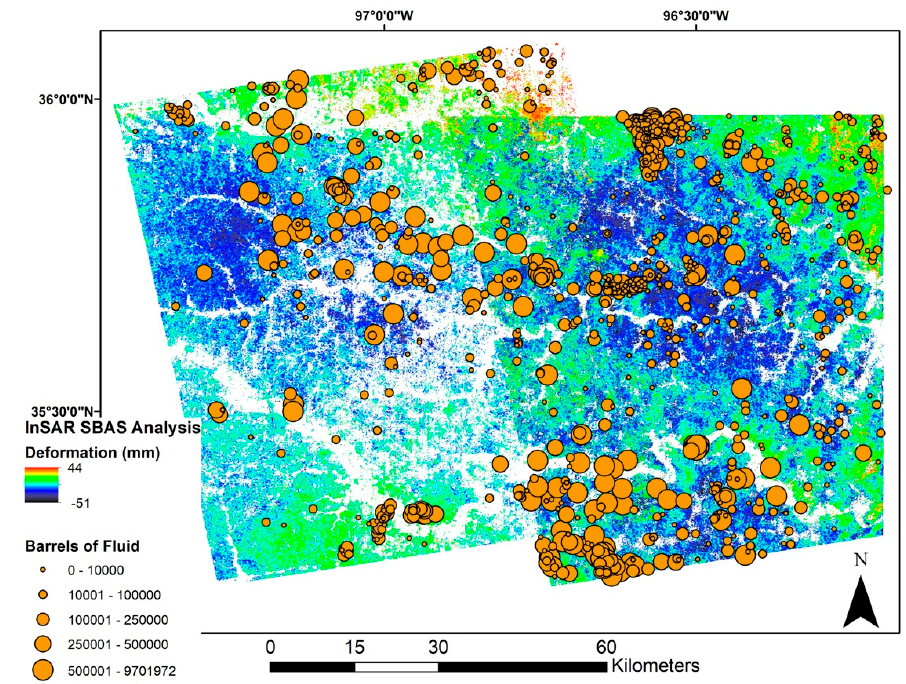
Figure 5. Regional Deformation and injection well volumes for 2011. Injection well fluid volume is shown in barrels of fluid over InSAR regional deformation. All deformation is measured in LOS. Negative values represent movement away from the satellite, whereas positive values indicate movement towards the satellite.